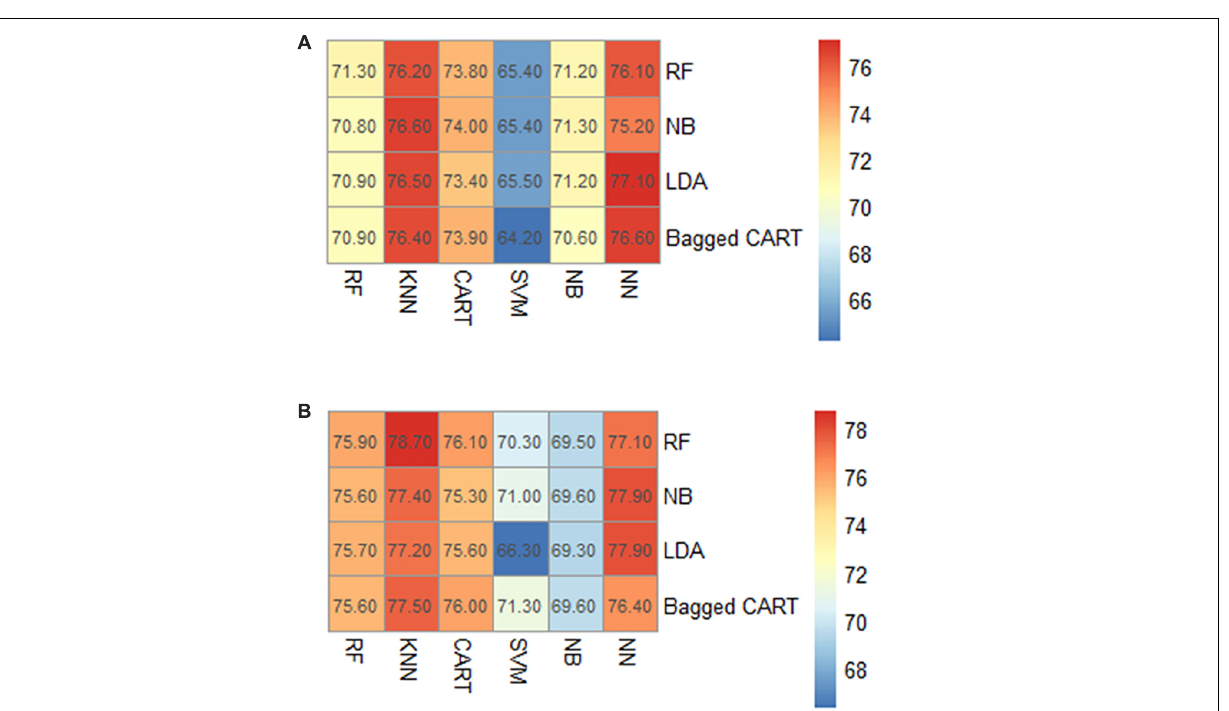
FIGURE 8 | AUC results of different algorithms. (A) Anti- E. coli model. (B) Anti- S. aureus model.